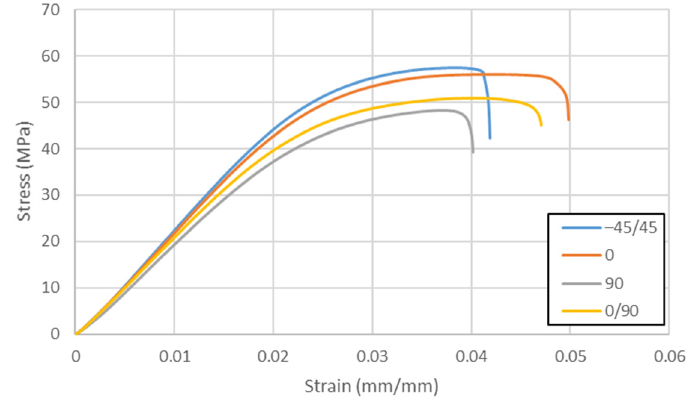
Figure 8. Representative Flexural Stress-Strain Curves.